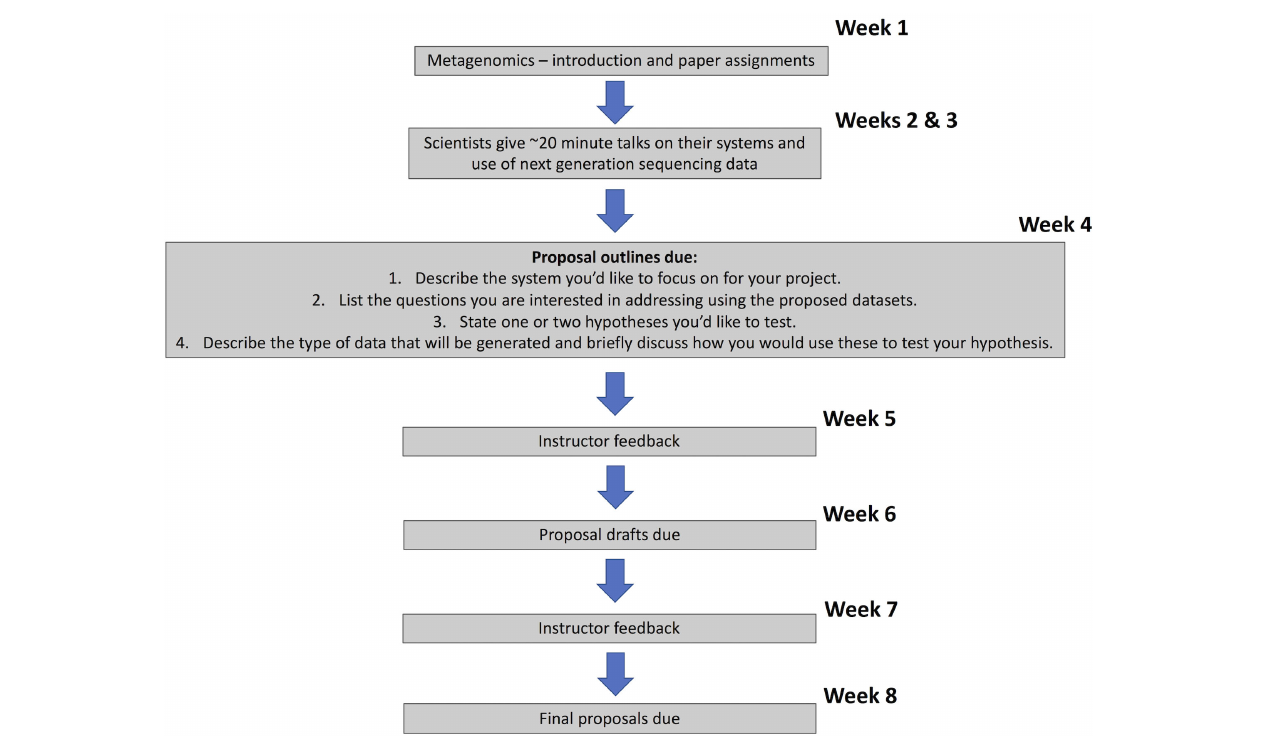
and situations in which to apply them; (2) course participation, which included a requirement that the students demonstrate competency in DNA extraction, PCR amplification, PCR primer design, and gel electrophoresis; (3) an 8 page paper in which they analyzed and reported data that they generated on a bacterial endosymbiont of ants, showing competency in DNA sequence alignments, BLAST searches, and phylogenetics; and (4) their 4–6 page microbiome analysis proposal. Skills emphasized in the class were, thus, not only related to lab techniques but also thinking like a scientist and analyzing and interpreting data.